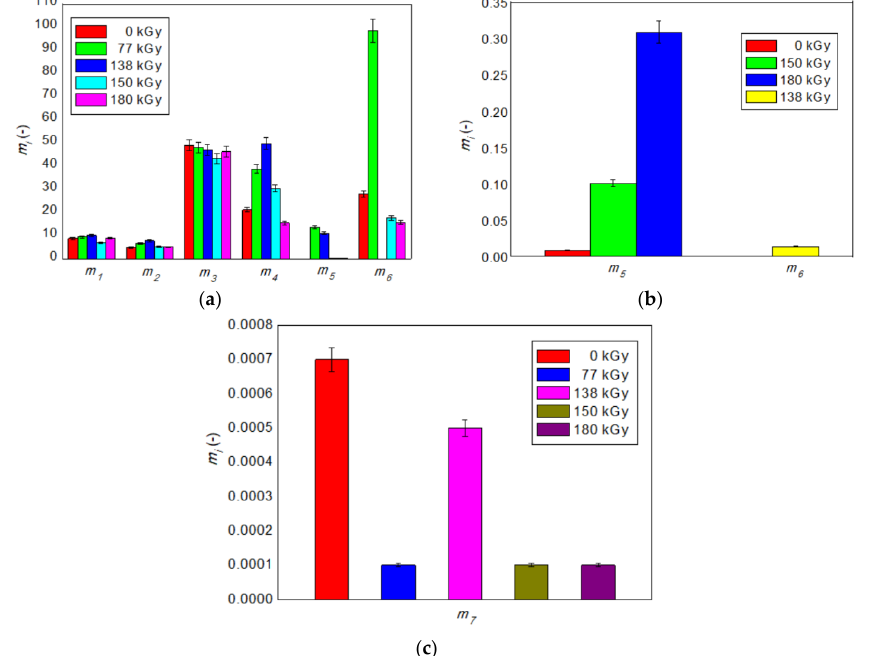
Figure 6. Influence of the radiation dose size on values of Weibull moduli: ( a ) m 1 – m 7 at radiation doses of 0, 77, 138, 150 and 180 kGy; ( b ) m 5 – m 6 at radiation doses of 0, 138, 150 and 180 kGy; ( c ) Weibull modulus m 7 at radiation doses of 0, 138, 150 and 180 kGy.